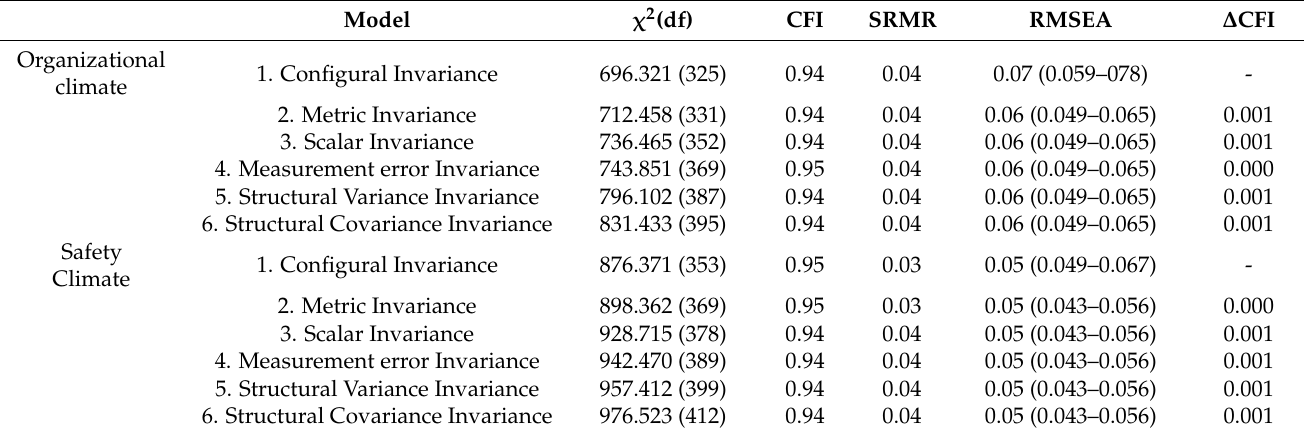
Table 4. Fit statistics for measurement invariance by company